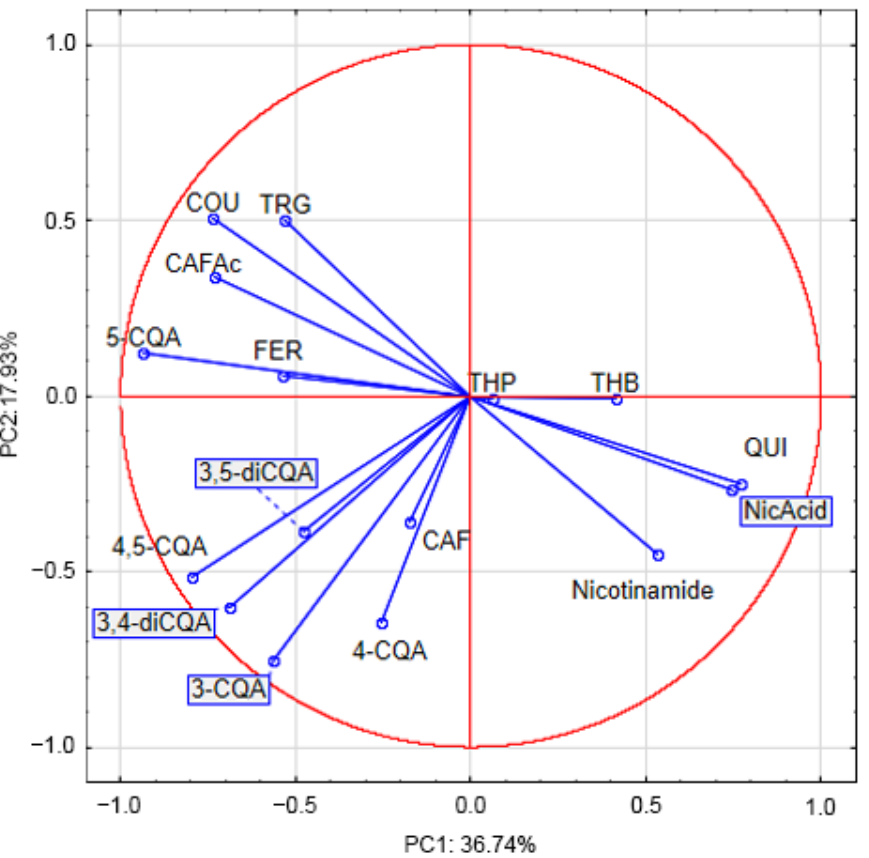
Figure 9. Principal Component Analysis — Projection of variables (TRG — trigonelline; COU — cou-